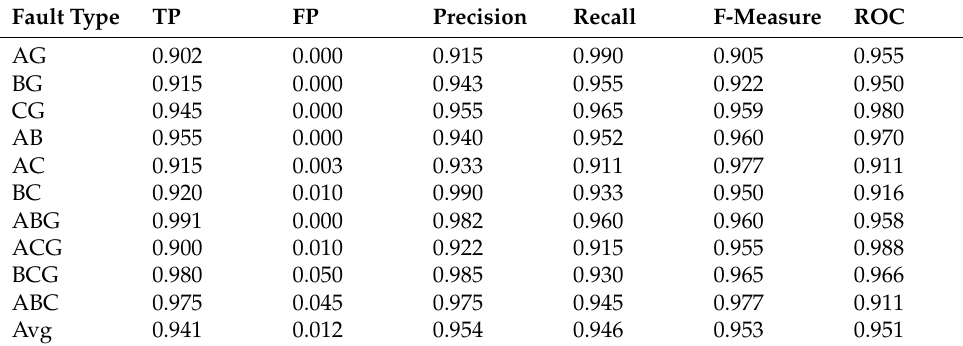
Table 7. SVM classification with single cycle